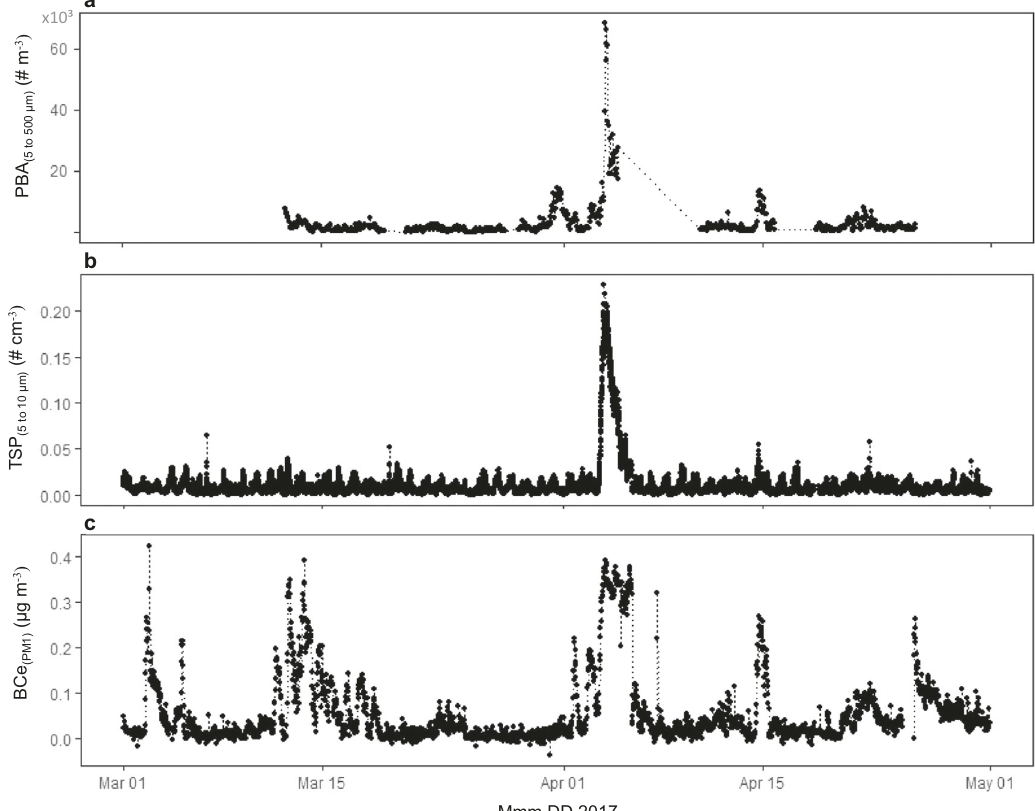
Fig. 5 High PBA concentrations observed during the wet season at 300 m when reduced local emissions are often registered. The sampled peak in particles ( a ) from 5 to 500 µm follows the same pattern seen in the narrow range ( b ) 5 – 10 µm; c equivalent black carbon highlights the smoke